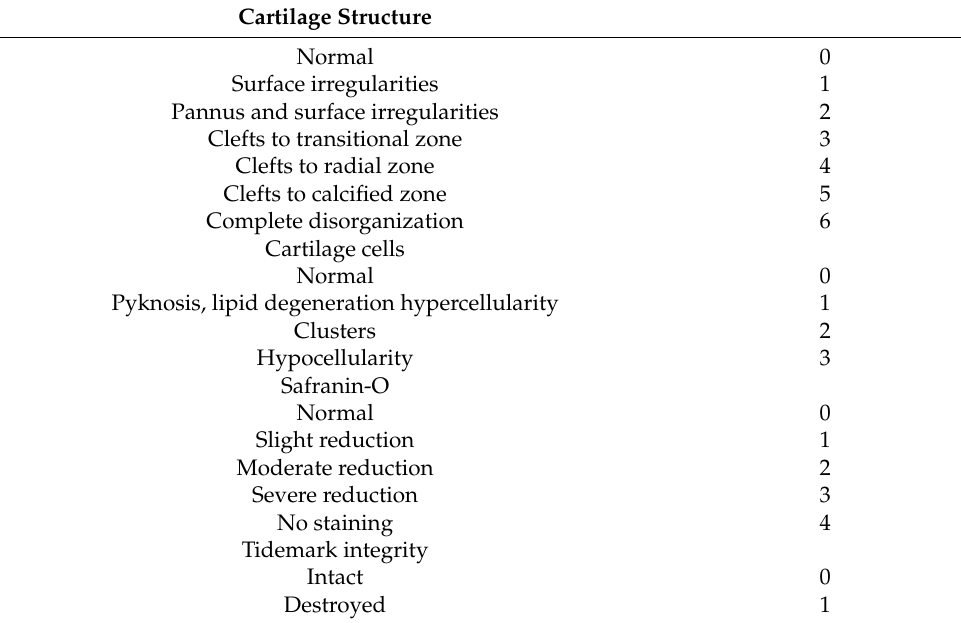
Table 2. Modified Mankin scoring